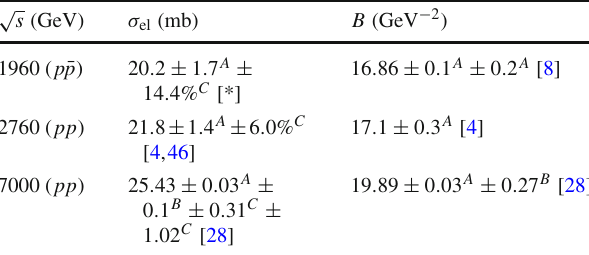
√ s = 1 . 96 TeV as measured by the D0 experiment at Tevatron [8]. This table indicates that the Odderon signal is observed in this compar- ison with at least a 6.26 σ significance, corresponding to an Odderon